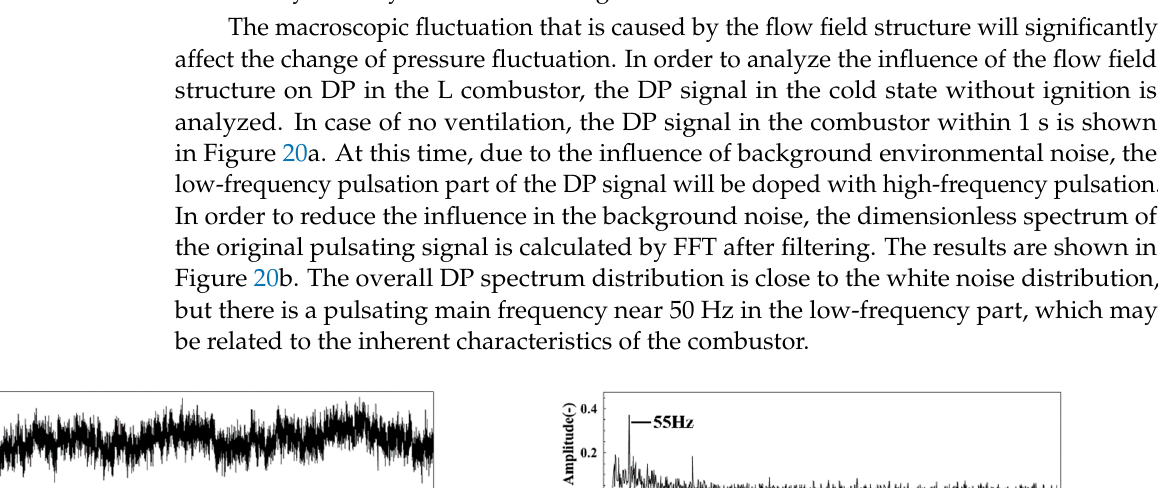
Figure 19. Variation of the proportion of pulsation peak energy of each order component of DP: ( a ) IMF1; ( b )IMF2; ( c ) IMF3.